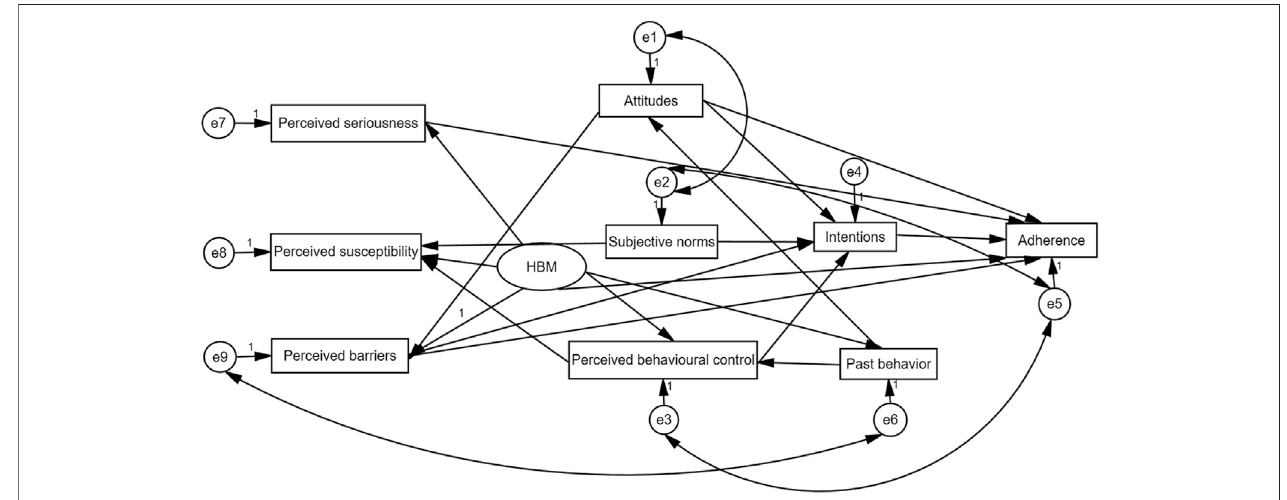
FIGURE 2 | Summary of regression results of the combined theory model dimensions.